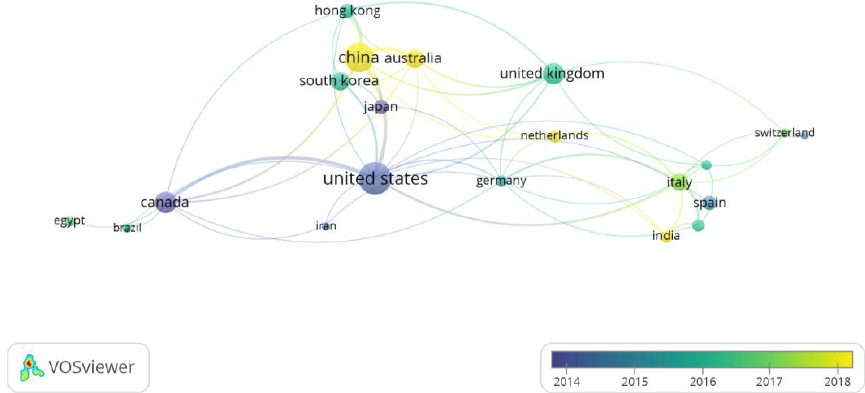
Figure 8. Co-authorship network regarding